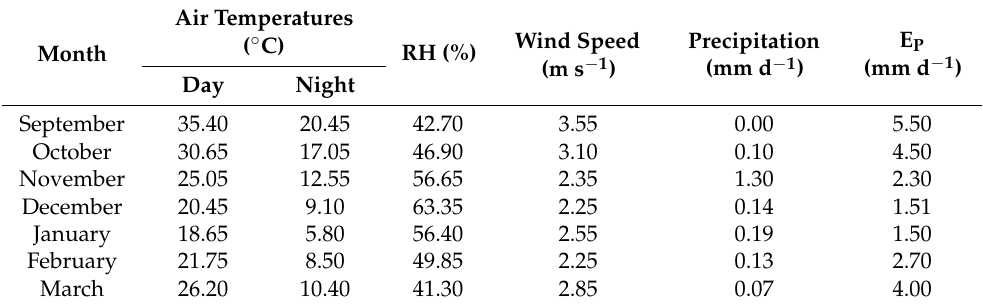
Table 1. Averages of some meteorological indices per month during experiment period at El-Fayoum province, Egypt (data pooled over both growing